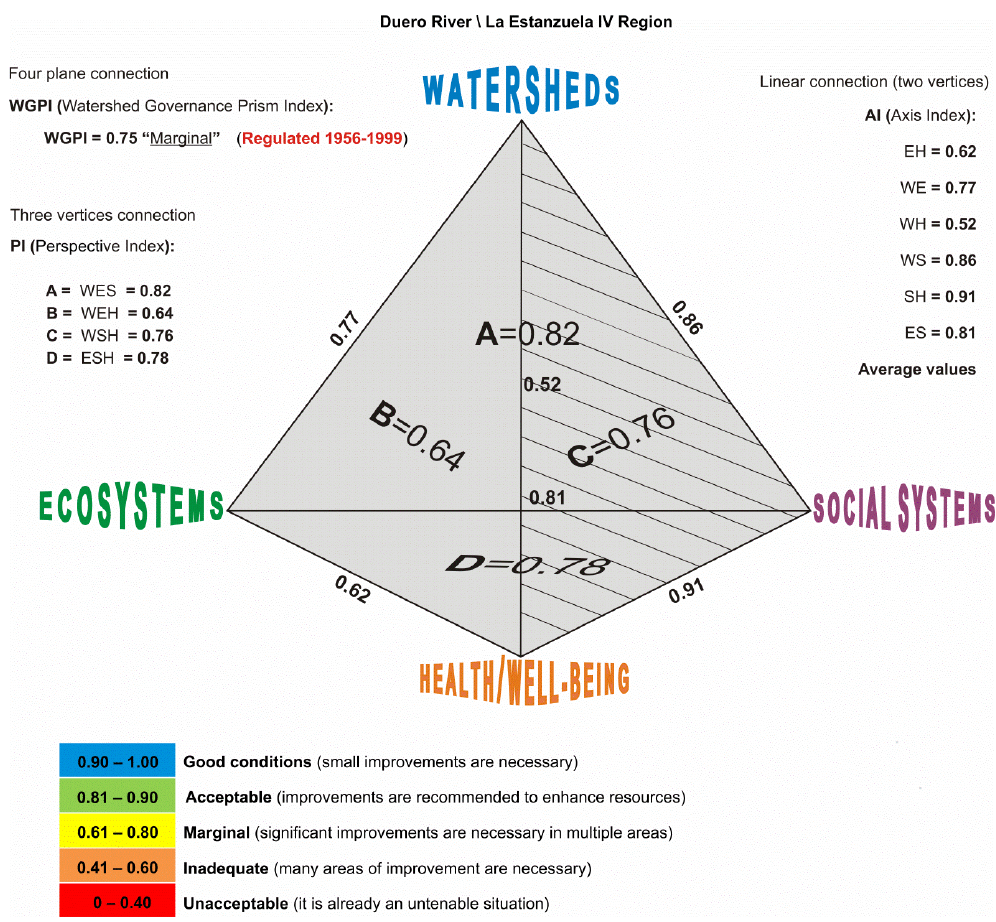
Figure 9. Numerical representation of the WGP theoretical framework [11] created through the proposed evaluations of the AI (with an evaluation for each axis), PI (with an evaluation for each governance perspective), and WGPI (with an average value between the four values of PI) for the regulated analysis period. Modified rating scale [52]. Source: own elaboration based on Parkes et al. [11].